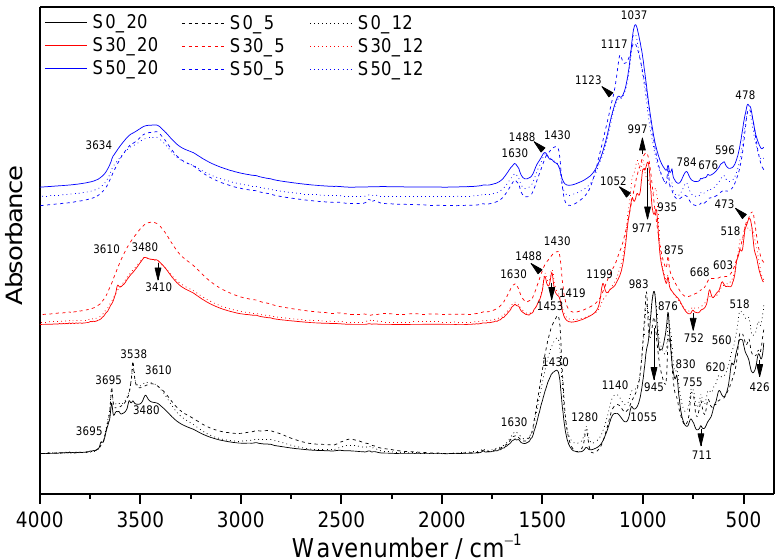
Figure 3. Comparison of MIR spectra of samples with different compositions and hydrothermal curing conditions.